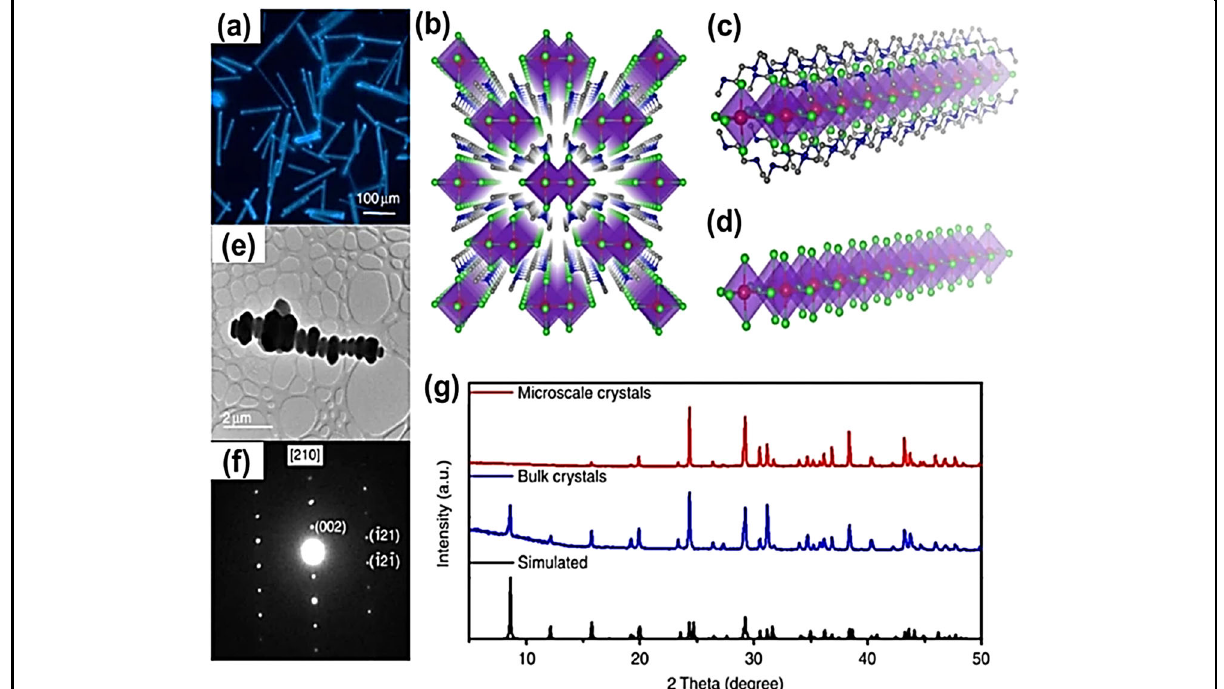
Fig. 9 Characterization of 1D molecular C 4 N 2 H 14 PbBr 4 . a Optical image showing 1D MHP single crystals. b Structure of 1D C 4 N 2 H 14 PbBr 4 . View of an individual lead bromide quantum wire with c and without d wrapped organic cations. e TEM image of microscale 1D perovskite crystals. f Electron diffraction pattern along the [210] zone axis. g Powder XRD patterns for bulk and microscale 1D MHP crystals, as well as simulated patterns. Reproduced with permission from ref. 111 . Copyright 2017, Nature Publishing